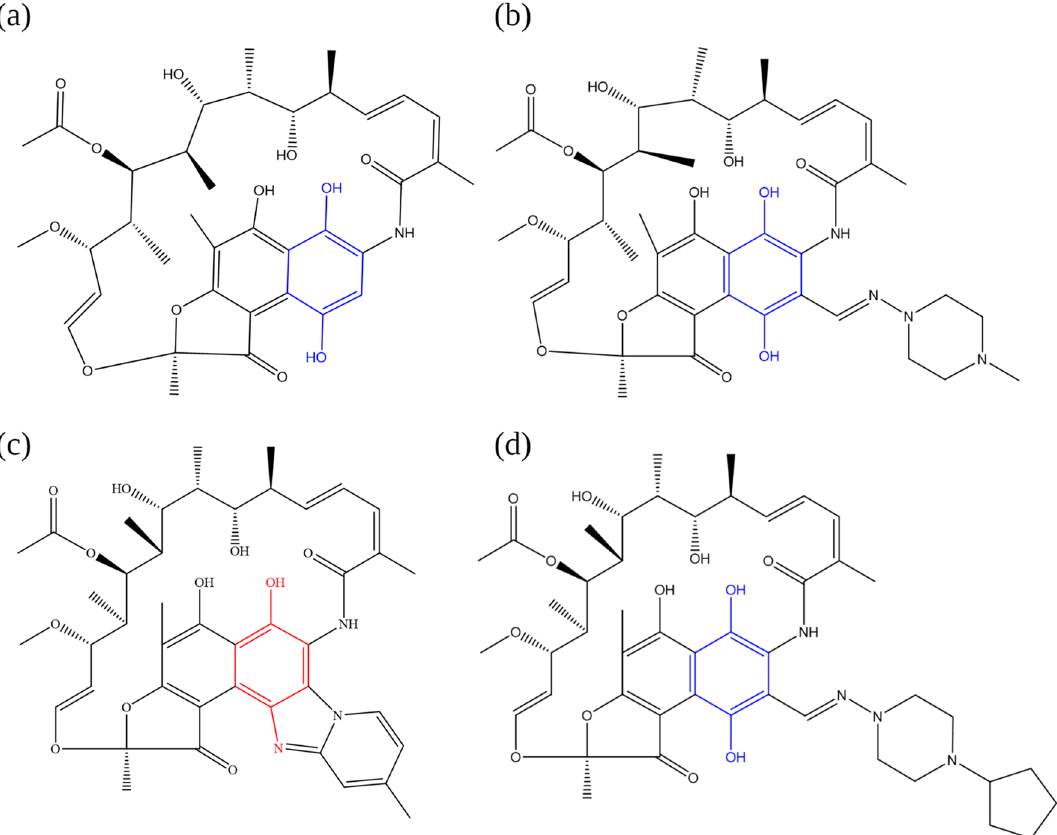
Figure 5. Chemical structure of ( a ) rifamycin SV ( b ) rifampicin ( c ) rifaximin and ( d ) rifapentine. The para-dihydroxynaphthyl moiety possessed by rifamycin SV, rifampicin and rifapentine is highlighted in blue. Rifaximin possesses a para-aminophenyl moiety incorporated in a ring system, highlighted in red 68 . The figure was designed in ChemDraw and redrawn from Golegaonkar et al . (2015) 68